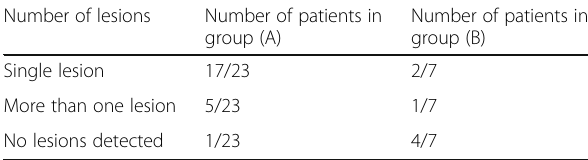
Table 1 The number of detected lesions in both groups Number of lesions Number of patients in Number of patients in group (A) group